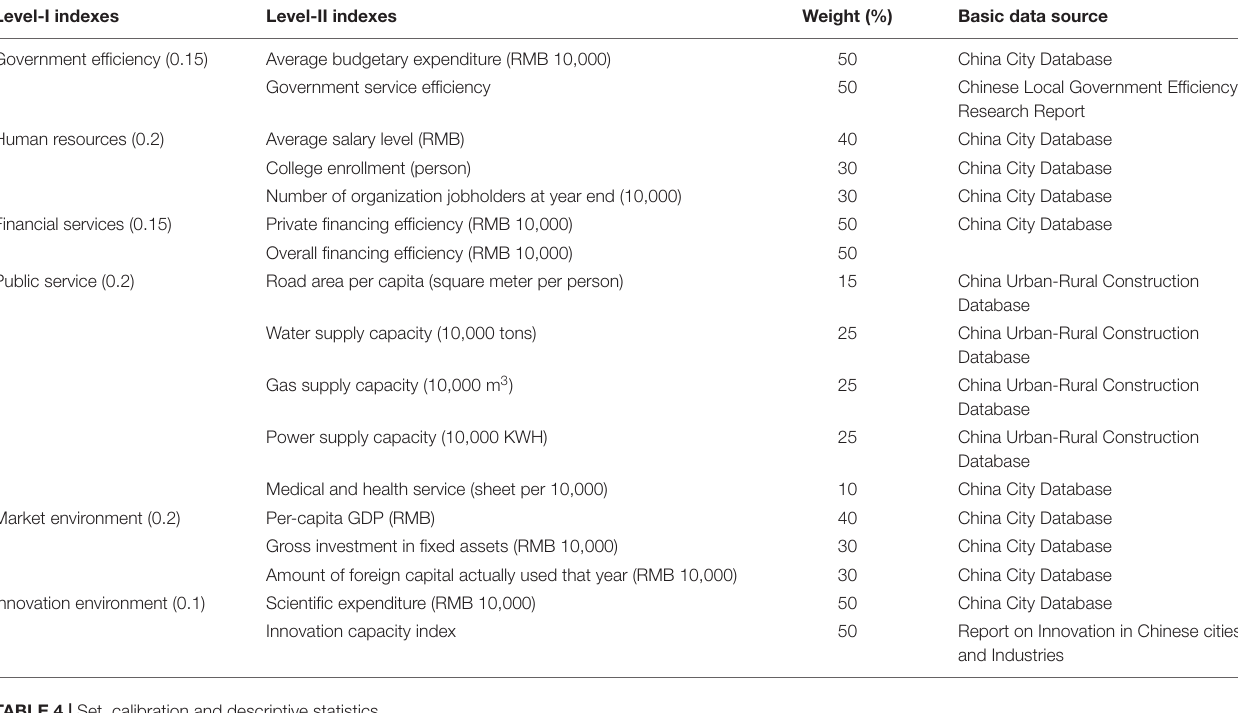
TABLE 3 | Index evaluation system of antecedent condition.